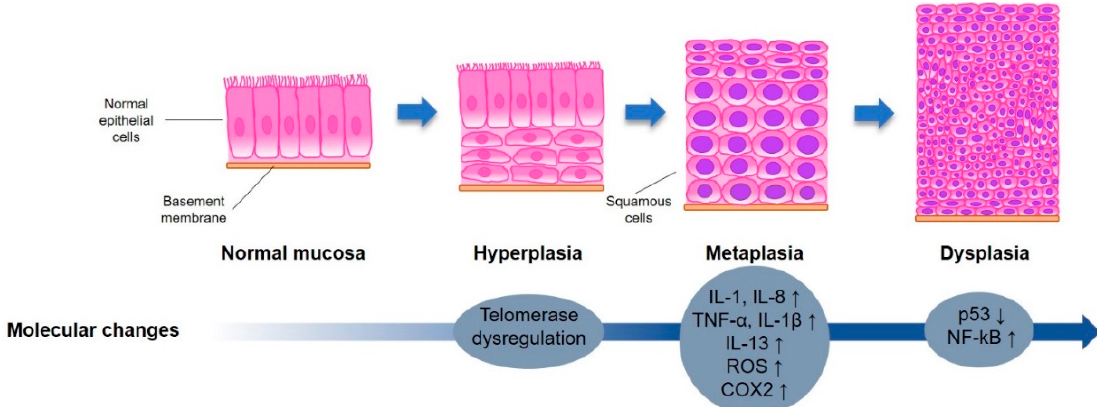
Figure 1. Stages of morphological cellular adaptations and molecular changes leading to lung cancer. Representative illustration highlighting morphological alterations of the epithelial cells during the gradual transition towards lung cancer and key molecular alterations contributing to this process.